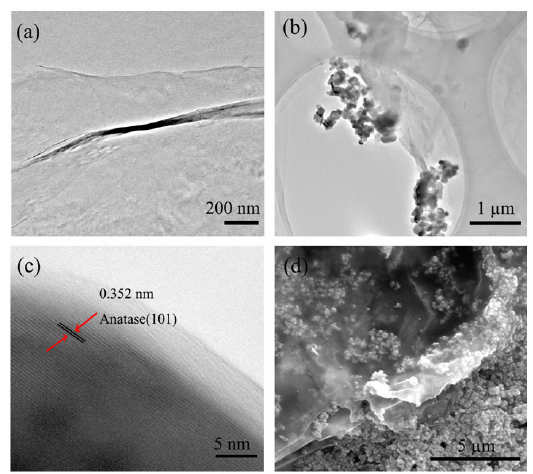
Fig. 1 (a) TEM image of NG; (b) TEM and (c) HRTEM images of MnO x –CeO 2 /TiO 2 –1%NG; (d) SEM image of MnO x –CeO 2 /TiO 2 –1%NG.